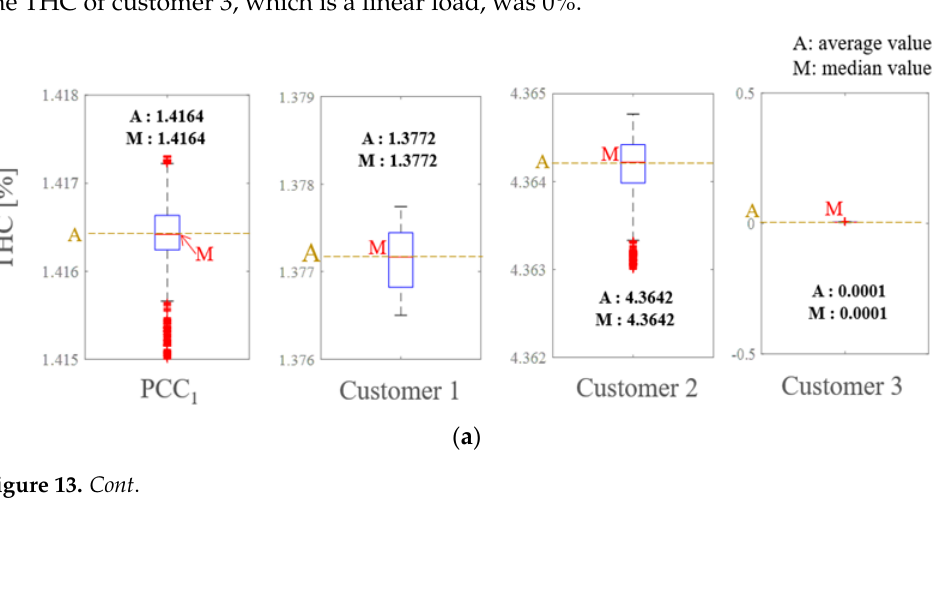
Table 4. The assessment results of HVC and HCR for the 3rd, 5th and 7th orders.